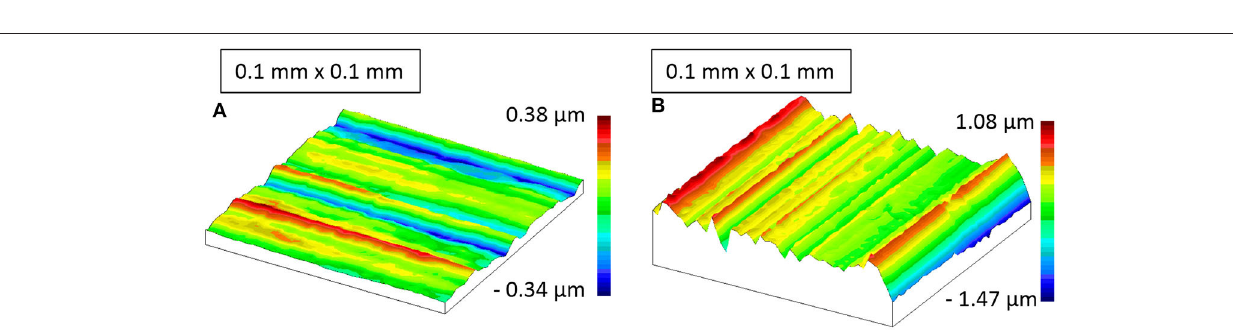
FIGURE 9 | (A) Honed surface (Sdq = 0.452; Sdr = 9.367%); (B) Electric discharge machined surface (Sdq = 0.459; Sdr = 9.010%).